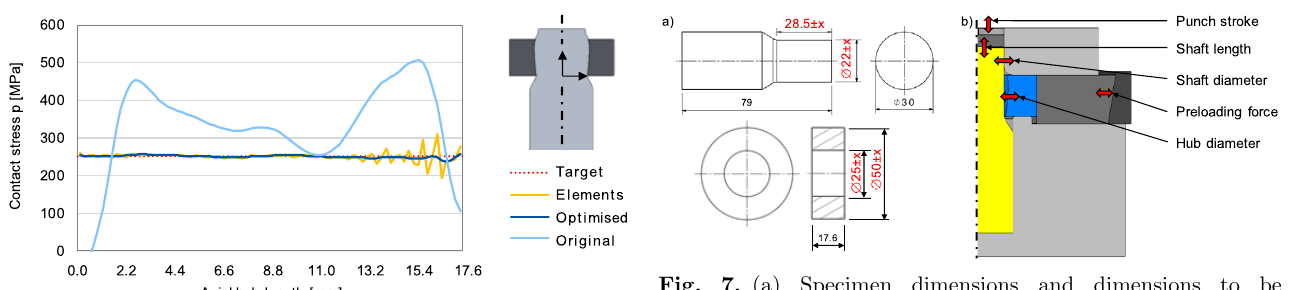
Fig. 7. (a) Specimen dimensions and dimensions to be investigated (marked in red); (b) illustration of machine and tool tolerances in numerical-simulation